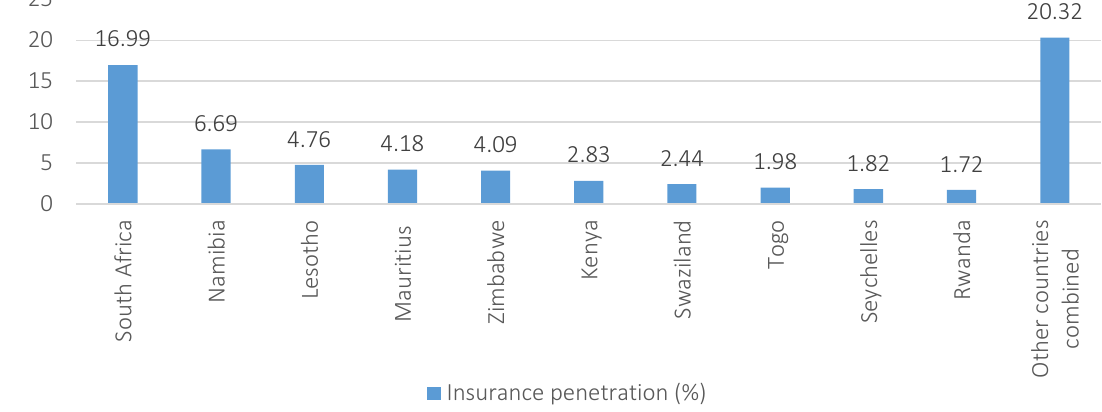
Figure 1. Sub-Saharan African countries insurance penetration in